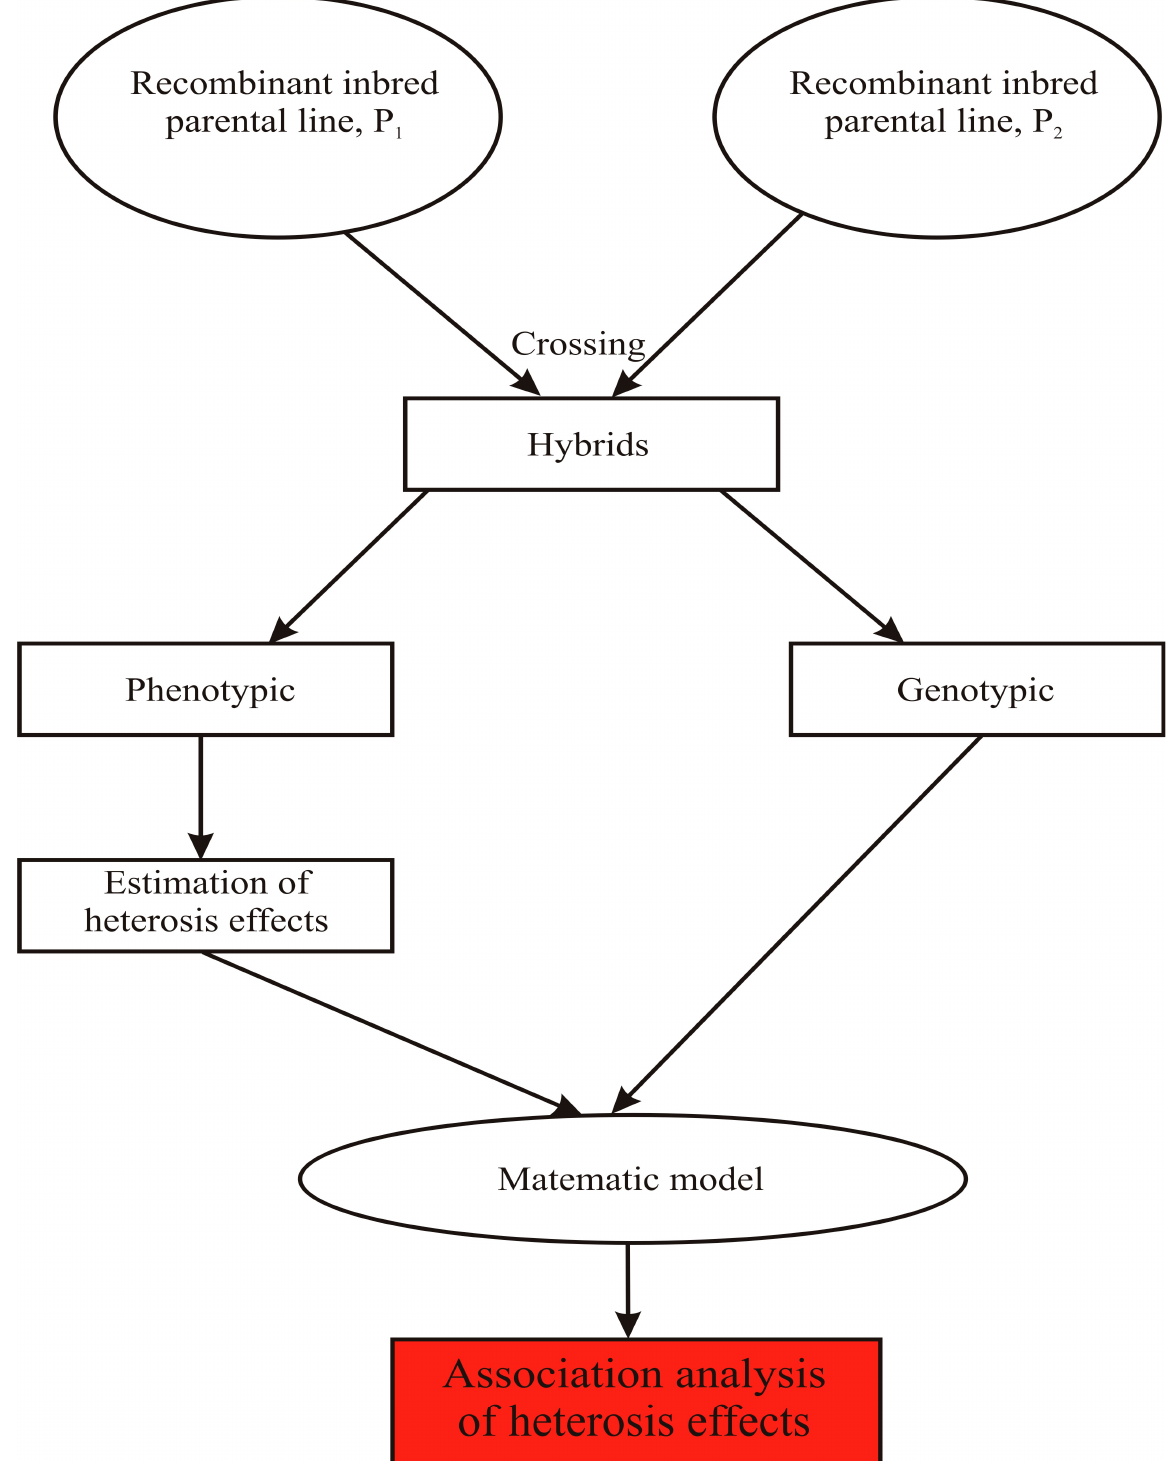
Figure 1. The plan of work.